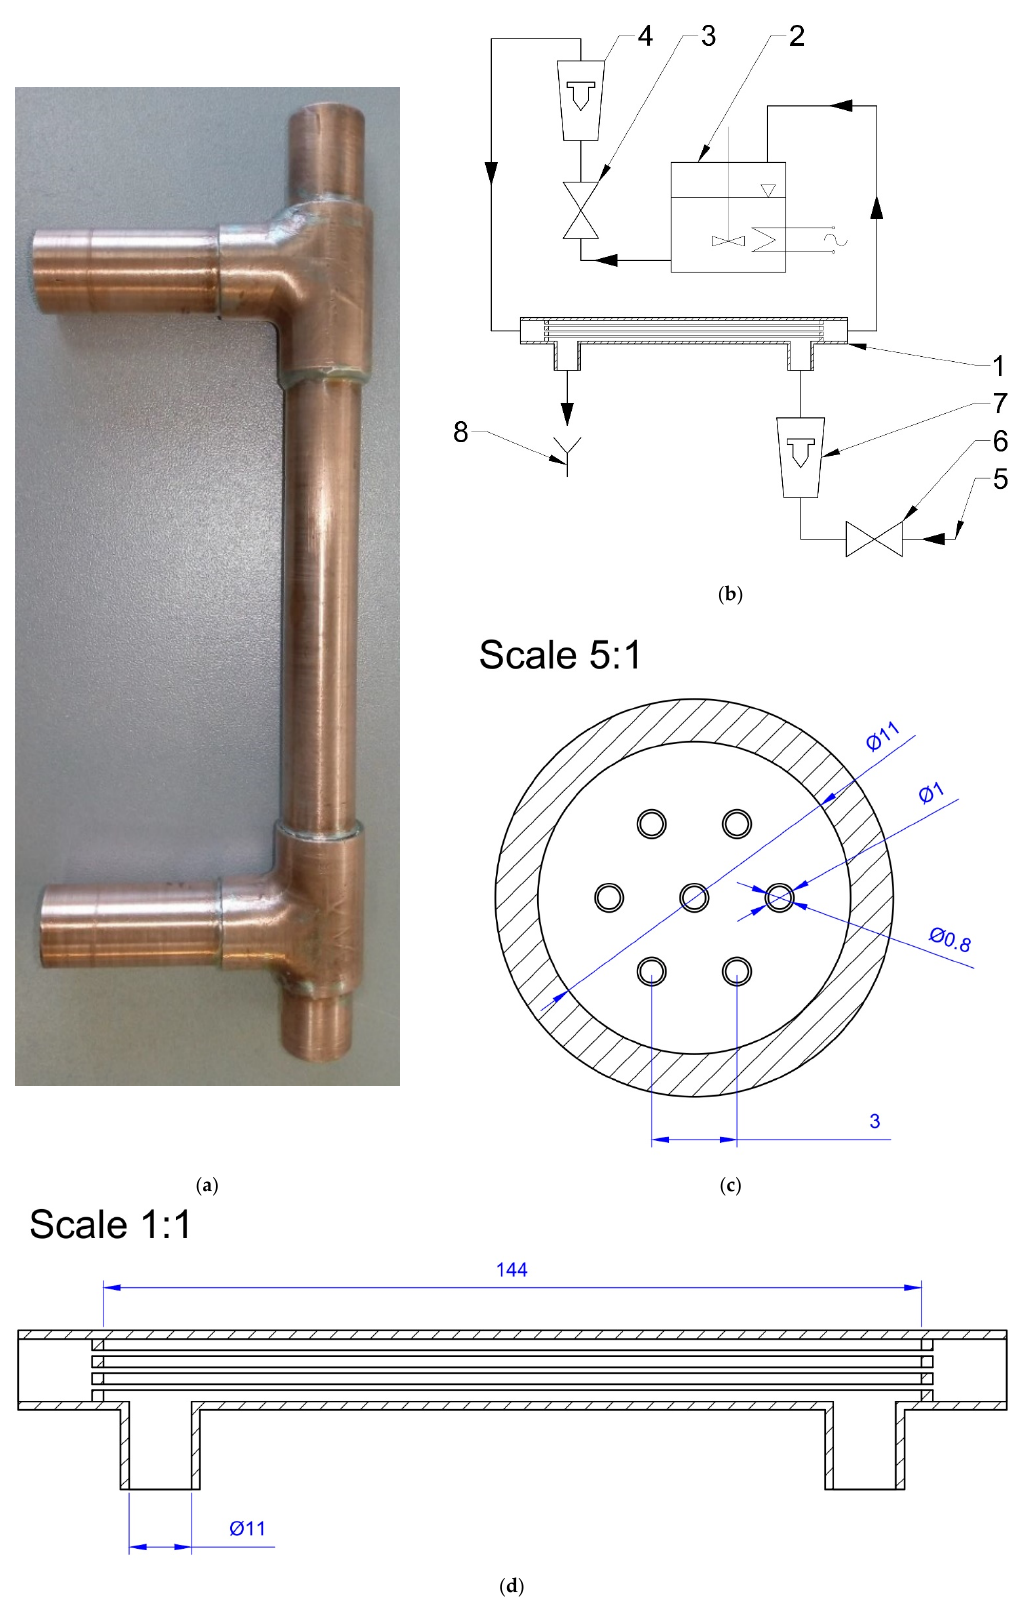
Figure 1. ( a ) Investigated shell and tube mini heat exchanger (STMHE); ( b ) Experimental setup: 1—STMHE, 2—thermostatic vessel, 3—valve, 4—rotameter, 5—old water supply, 6—valve, 7—rotameter, 8—cold water drain; ( c ) cross section drawing of the investigated STMHE in 5:1 scale; ( d ) longitudinal section drawing of the investigated STMHE in 1:1